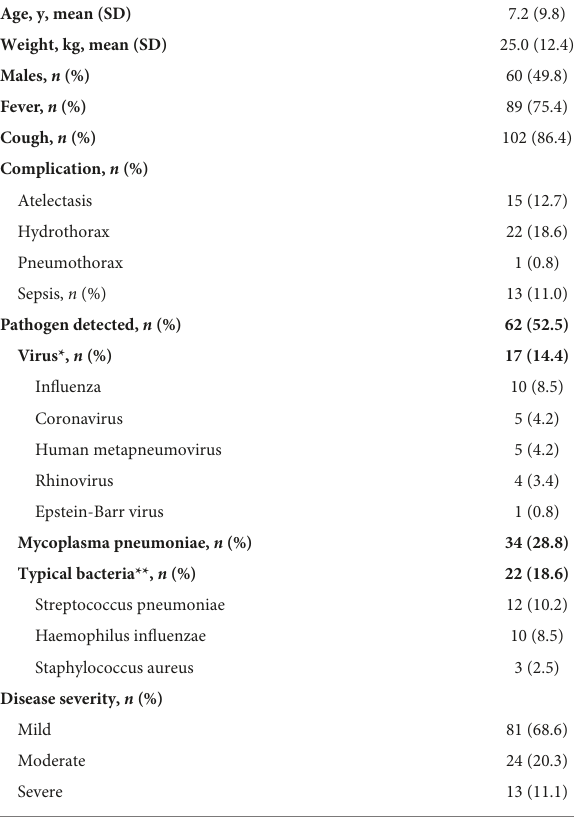
showed no obvious trend with an increase in the